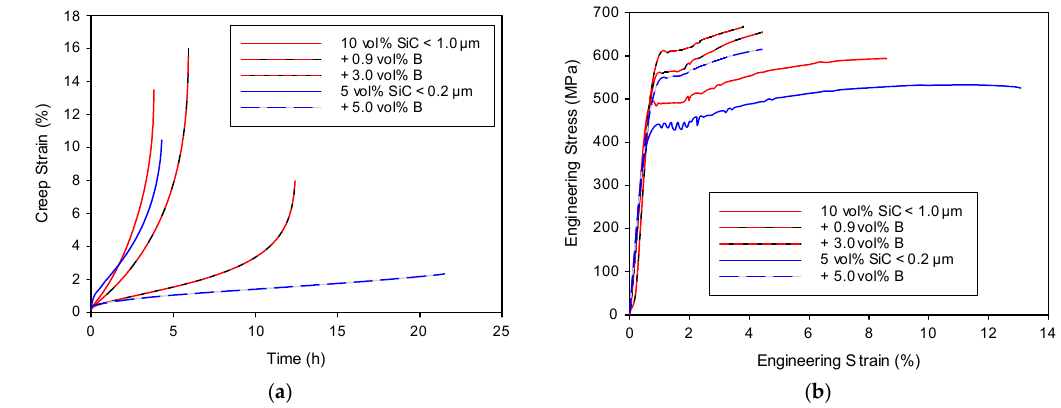
Figure 1. Influence of boron content on selected mechanical properties, based on: ( a ) tensile creep tests at a temperature of 180 °C and a stress of 200 MPa; ( b ) tensile tests.